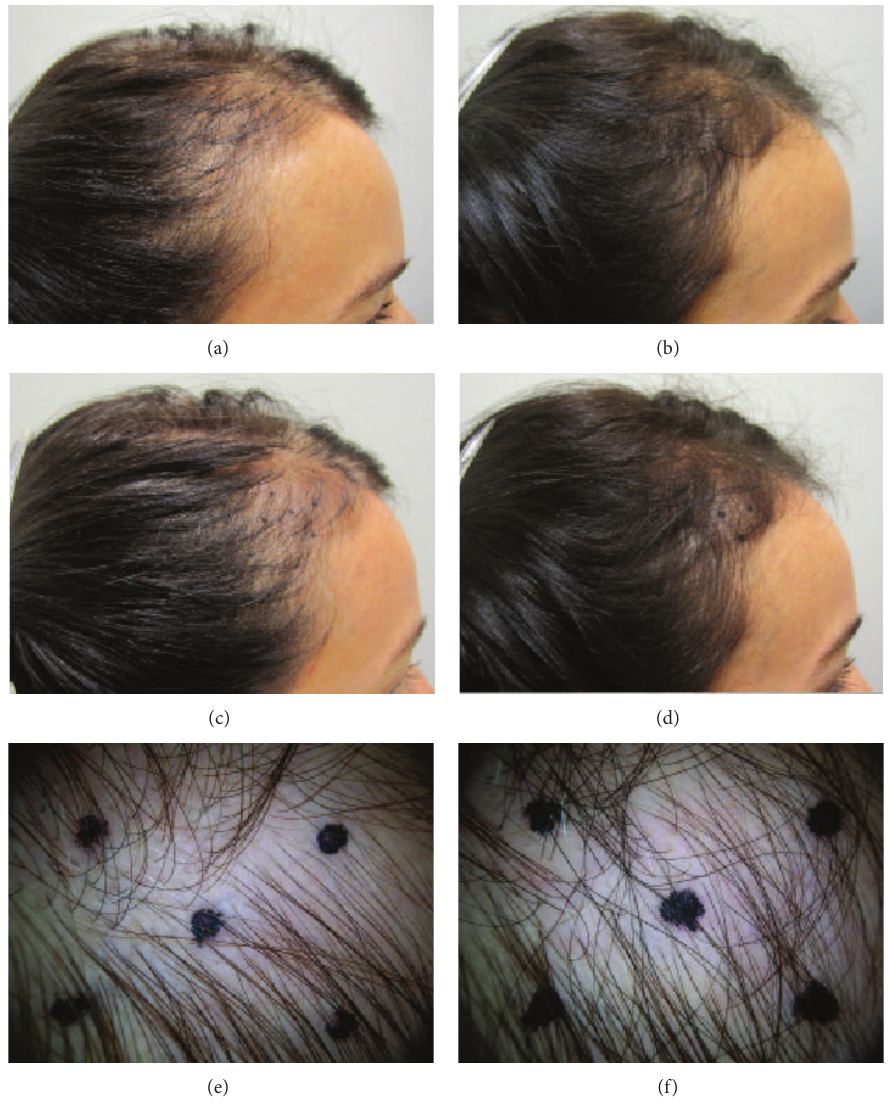
Figure 1: Subject 42. The number of terminal and vellus hairs at baseline (left) increased significantly after 90 days of treatment (right). The 4 cm 2 target area of the scalp is shown in the middle and bottom